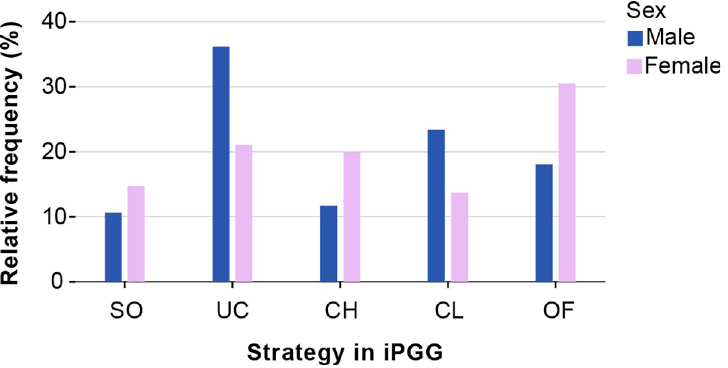
Fig 2. The frequency distribution of strategies in the iterated Public Goods Game in male and female participants. Self-oriented (SO): always invested < 50% of own funds into common pool; Unconditional cooperator (UC): always invested � 75% of own funds, even if in previous rounds cooperation failed; Conditional, Starting High (CH): started with high investments and further declined (at least in one of subsequent interactions); Conditional, Starting Low (CL): entered interactions with low investments, but increased over the course of the game (at least in one of subsequent interactions); Occasional Free-rider (OF): invested 0 or suddenly crucially reduced investments amid high investments of other participants in the